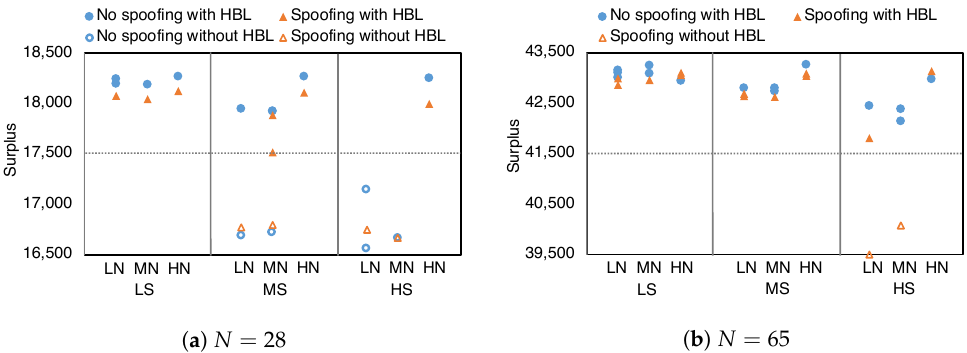
Figure 8. Total surplus achieved at equilibria in games with and without spoofing. Each blue (orange) marker specifies the surplus at one equilibrium found in a specific game environment without (with) spoofing. Surplus achieved at equilibria combining HBL and ZI and equilibria with pure ZI are indicated by markers with and without fills,